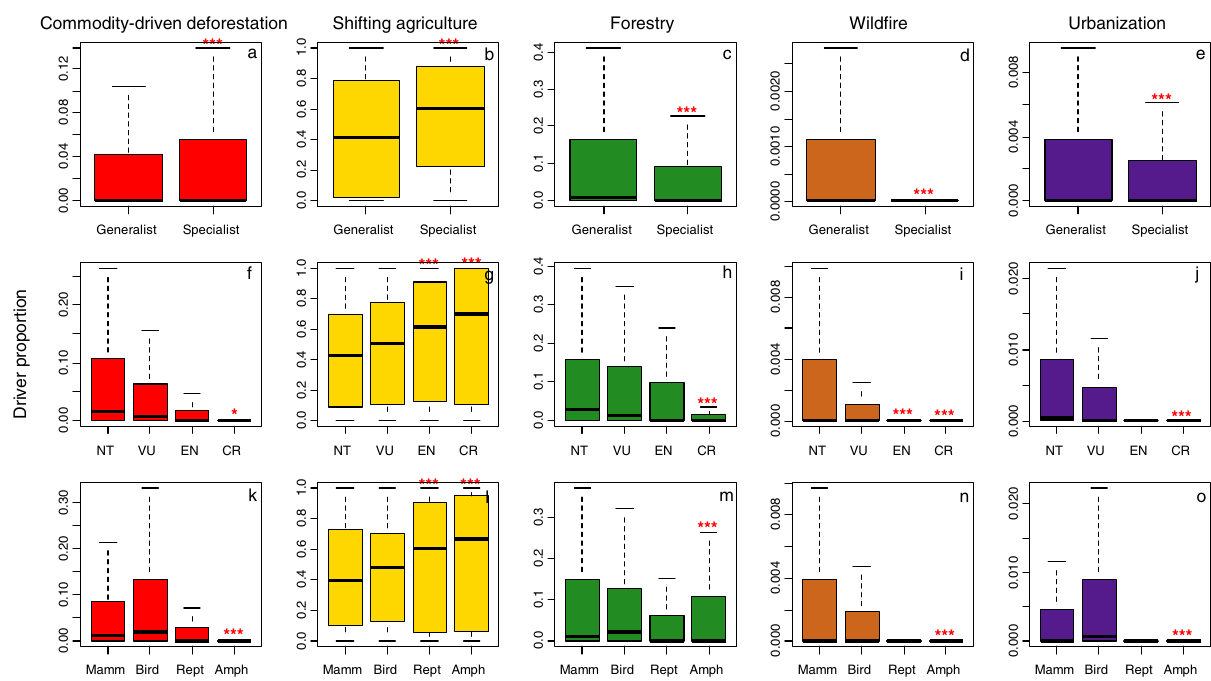
Fig. 2 Comparison of driver proportions among species groups. a – e forest habitat specialization (generalist or specialist); f – j threatened status on IUCN Red List (NT, near threatened; VU, vulnerable; EN, endangered; CR, critically endangered); k – o taxonomic class (mammal, bird, reptile, amphibian). Center line, median; box limits, upper and lower quartiles; whiskers, 1.5× interquartile range. In the Dirichlet regression, all categorical variables were considered at the same time as explanatory variables (i.e., multiple regressions), and each category on the left (i.e., generalist, NT, mammal) was treated as the control. For the IUCN status, NT was selected as the control since it is the lowest risk category. Note that effect of subregion was also considered in the regression (Supplementary Fig. 2). Asterisks represent statistically signi fi cant positive effect of the category against the control category (* P < 0.05, ** P < 0.01, *** P < 0.001) in the Dirichlet regression using the proportion of zero/minor forest loss as baseline (see also Supplementary Fig. 2; Supplementary Table